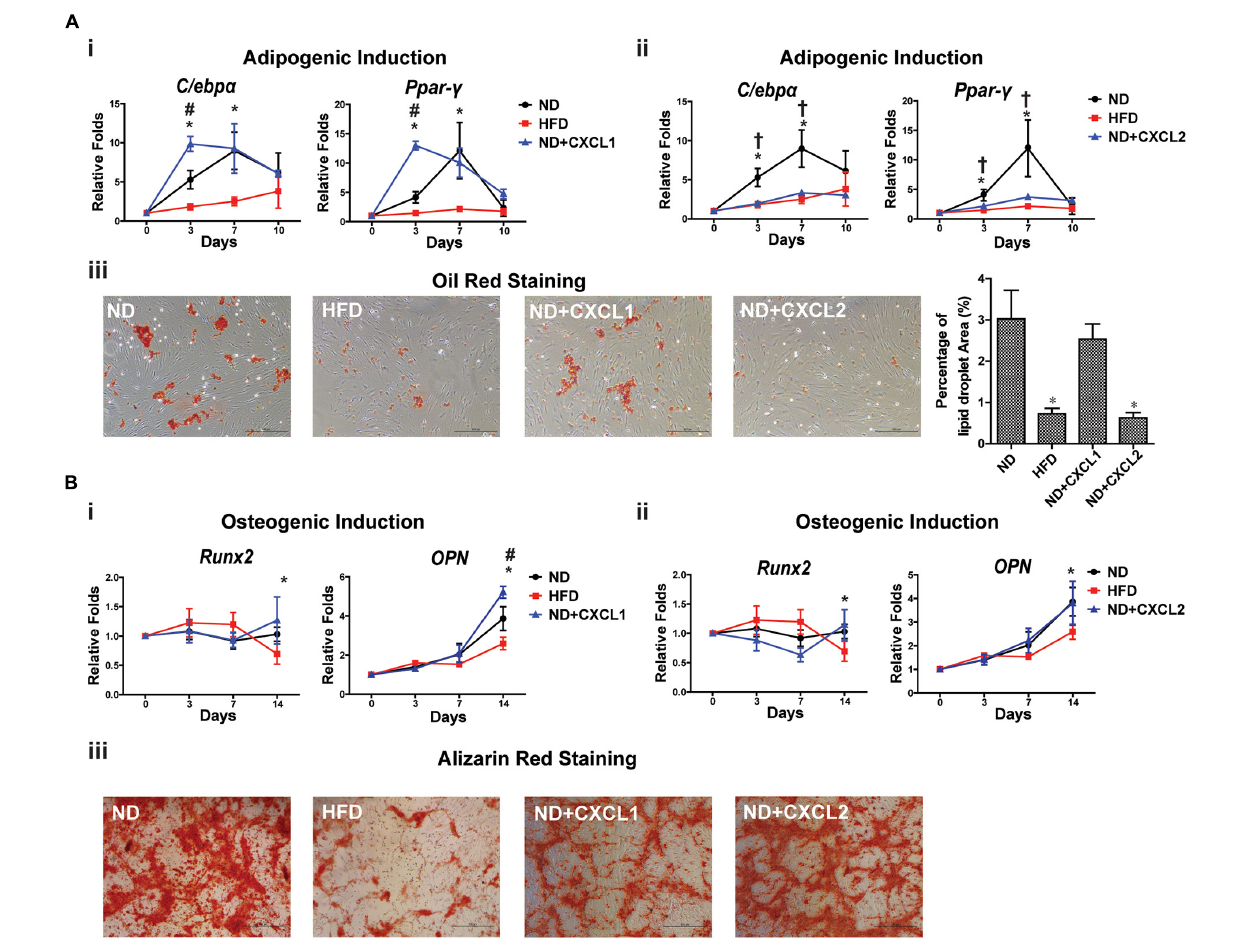
FIGURE 4 | CXCL2 affects the differentiation potentials of BMSCs in vitro . (A) Effects of CXCL1 (20 ng/ml) (i) and CXCL2 (50 ng/ml) (ii) on the expressions of adipogenic markers in BMSCs isolated from ND-fed rat during differentiation in vitro . Lipid droplets were visualized using Oil red O staining and the percentage of red-stained lipid droplets area were quantified by Image J (iii) . (B) Effects of CXCL1 (20 ng/ml) (i) and CXCL2 (50 ng/ml) (ii) on the expressions of osteogenic markers in BMSCs isolated from ND-fed rat during osteogenic differentiation in vitro . The mineralized nodules in the BMSC culture were detected using alizarin red staining (iii) . Data are represented as mean ± SEM ( n = 4). Significance was calculated by one-way ANOVA followed by Tukey’s post hoc test, * p < 0.05 (ND versus HFD), # p < 0.05 (ND versus ND + CXCL1), † p < 0.05 (ND versus ND +